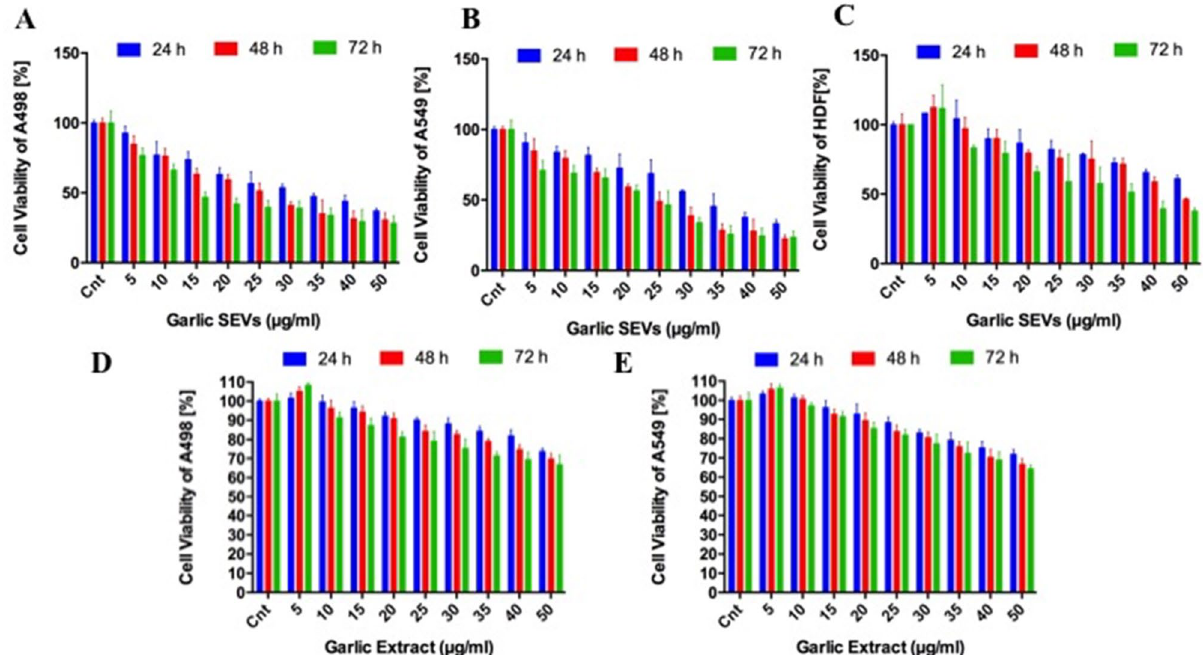
Figure 2. Analysis of the cell viability for human kidney carcinoma, A-498 ( A ), human lung carcinoma, A-549 ( B ) and normal human dermal fibroblast (HDF) cell line ( C ) when treated with varying concentrations (5–50 µg/ml) of garlic exosome and analysis of the cell viability for human kidney carcinoma, A-498 (D) and human lung carcinoma, A-549 when treated with varying concentrations (5–50 µg/ml) of garlic juice ( E ). Cells were seeded on 96-well plates and allowed to attach overnight. MTS assay was performed at 24, 48, and 72 h incubation (37 °C, 5% CO 2 ) in DMEM supplemented with 10% FBS. Cell death was analyzed by correlating the absorbance value of nontreated control cells to 100. The percentage of cell viability was calculated by assigning the absorbance value obtained from NC: negative control, standard growth medium treated cells as